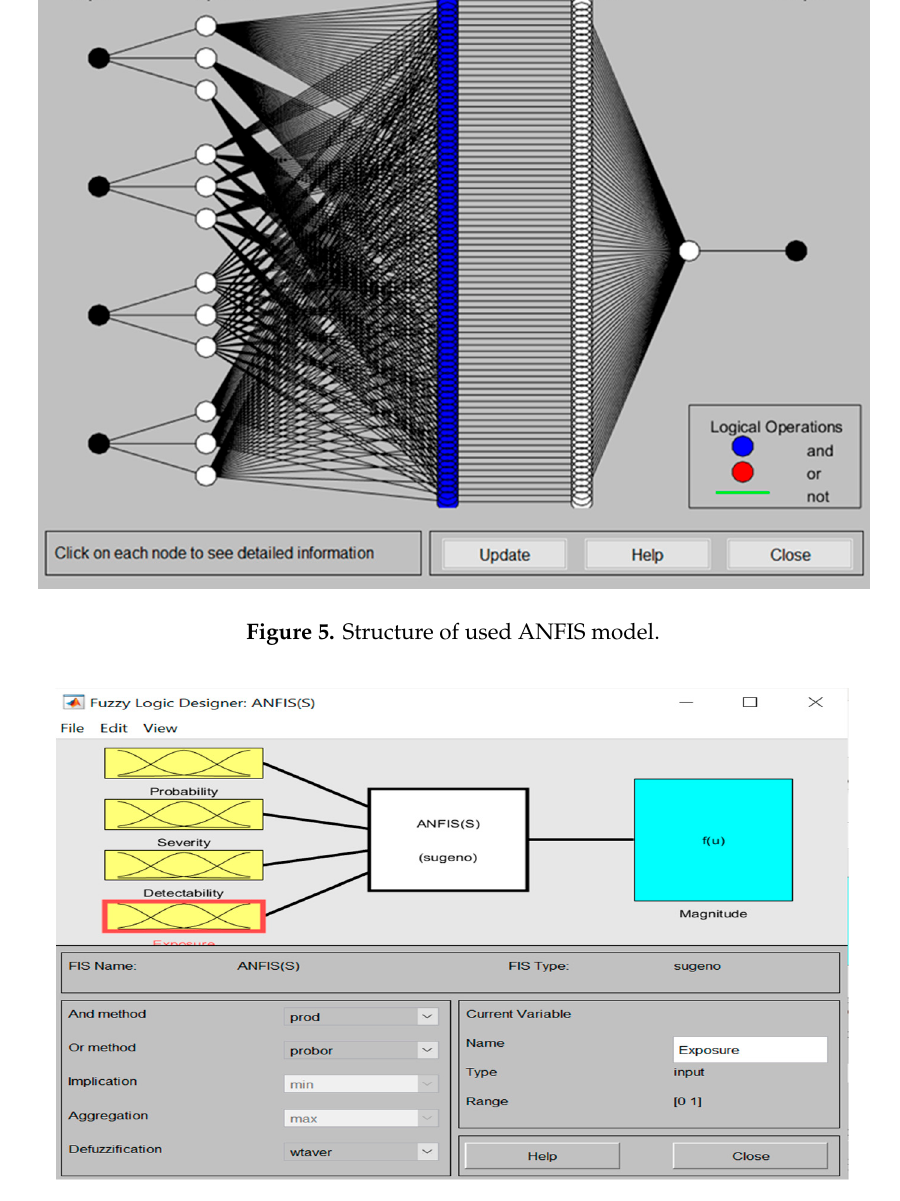
Figure 6. Inputs and output in ANFIS.